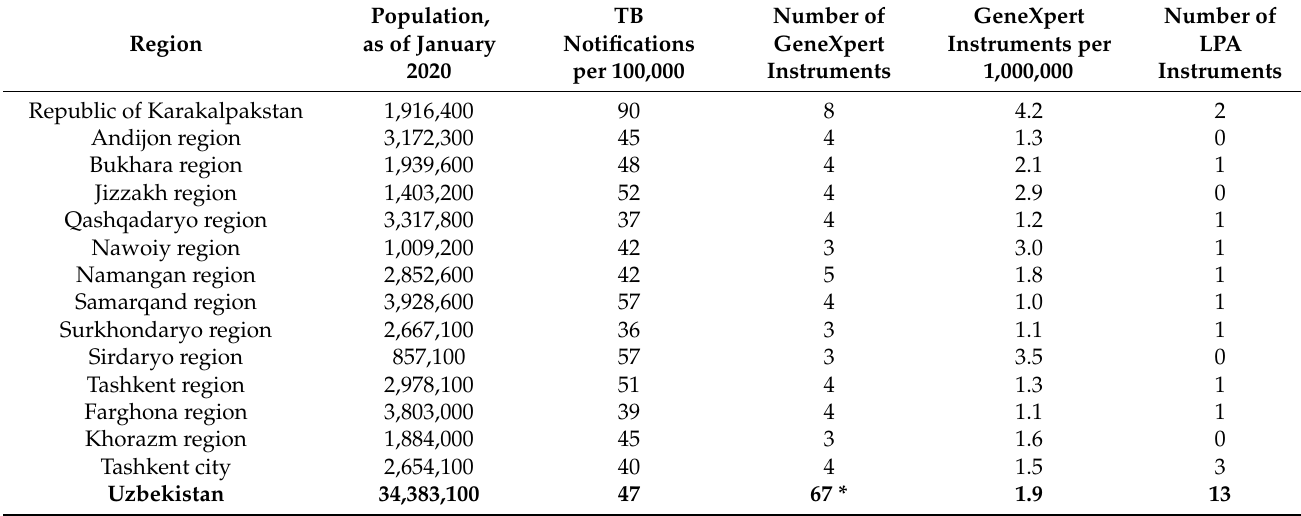
Table 1. Number of GeneXpert and LPA instruments deployed in Uzbekistan in 2019 by region. Population, Region